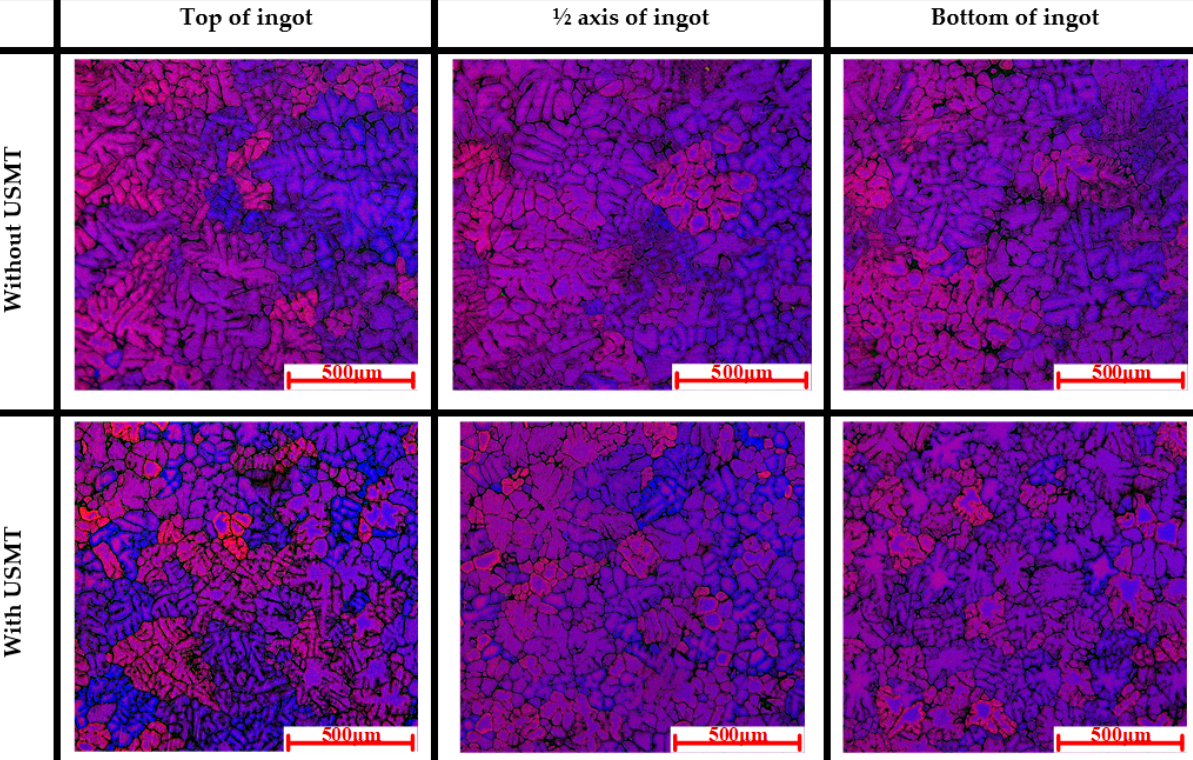
average size of α -Al grains decreases continuously from the middle part of the ingot to the two ends (top and bottom); this feature can be clearly seen in Figure 3. However, the rate of change in the α -Al grain size for the ingot formed using the ultrasonic melt treat-